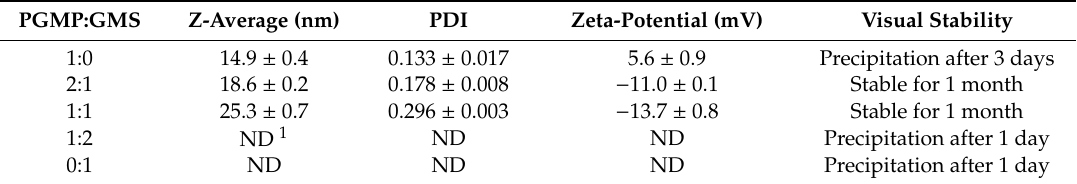
Table 1. E ff ects of mass ratio of PGMP and GMS on the Z-average mean diameter (Z-average), polydispersity index (PDI), zeta-potential, and visual stability of solid lipid nanoparticle